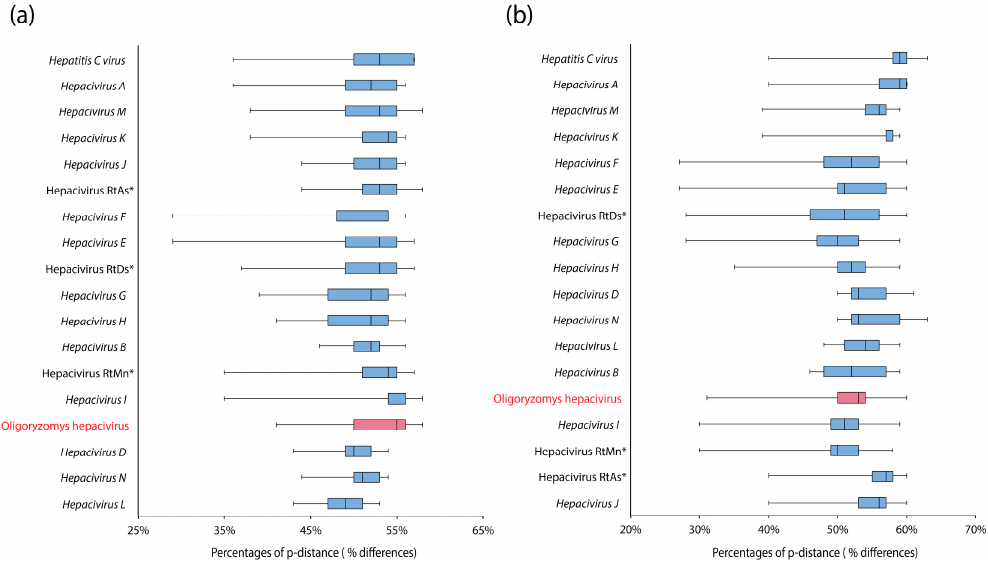
Figure 2. Amino acid p-distances of the OHV and representative members of the Hepacivirus genus in NS3 protease ( a ) and NS5 RdRp ( b ). The ends of the box represent the upper and lower quartiles, and the box spans the interquartile range. The median is showed by a black vertical line inside the box and the whiskers are the two lines outside the box that extend to the highest and lowest p-distance. The percentages of p-distance are shown in the X-axis and the representative members of Hepacivirus genus are shown on the Y-axis. The asterisks indicate the unrecognized species by ICTV. The novel hepacivirus is highlighted in red.